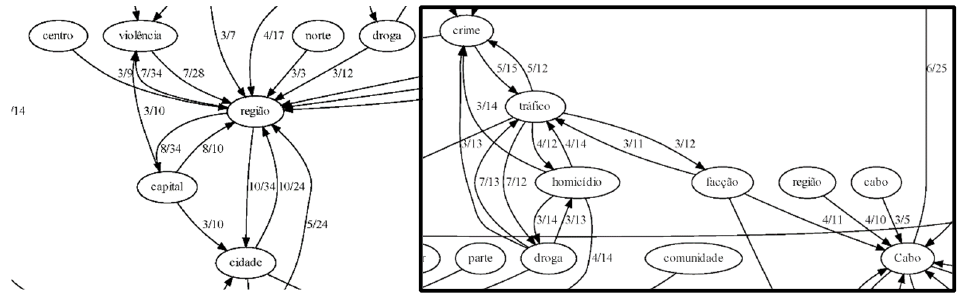
Figure 5. Selected regions of the co-occurrence graphs derived from interviews with BOPE officers before ( left ) and after ( right ) having viewed the VGI-generated map. The context binding of violence to crime to the drug trade in officers’ narratives features prominently.